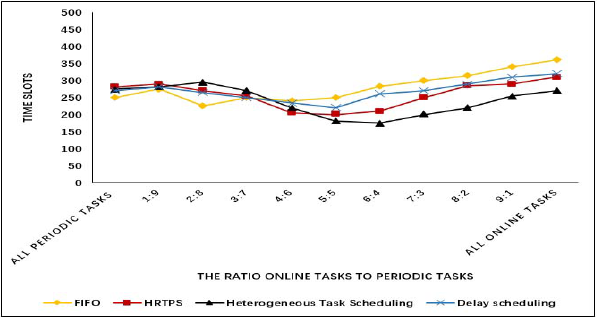
Figure 3. Experimental results of different